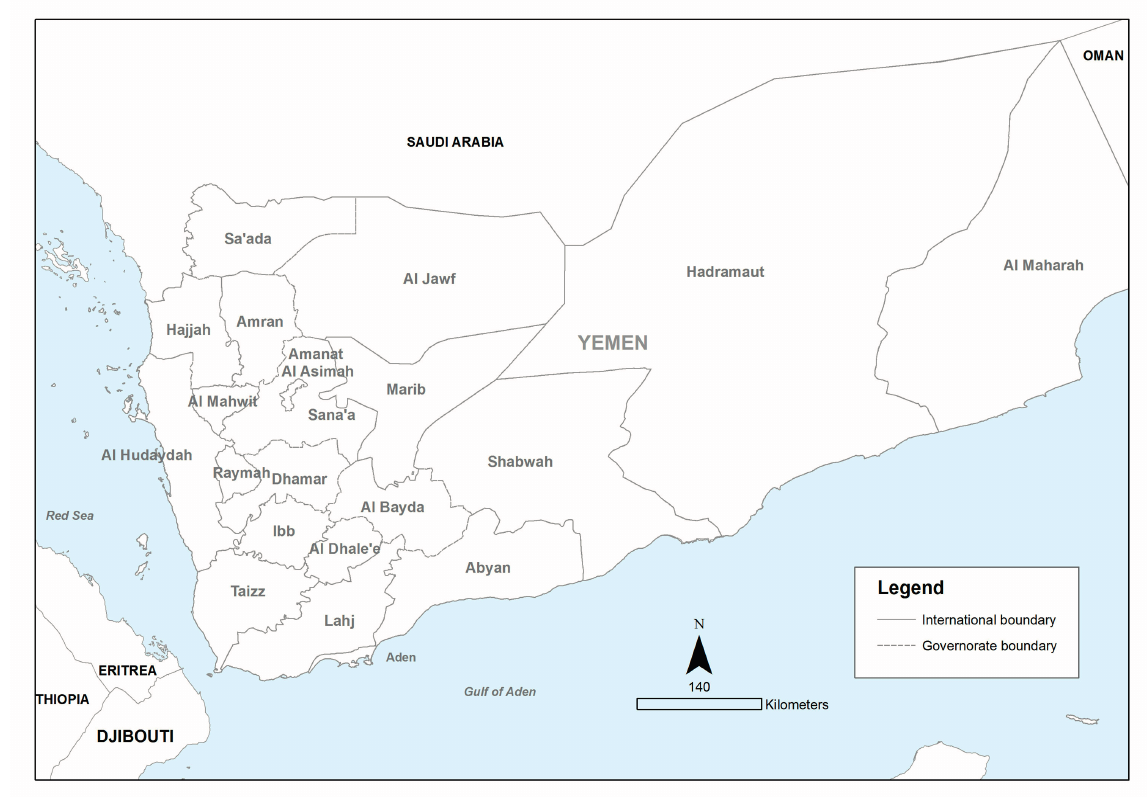
Figure 2. Map of Yemen showing administrative boundaries and locations of